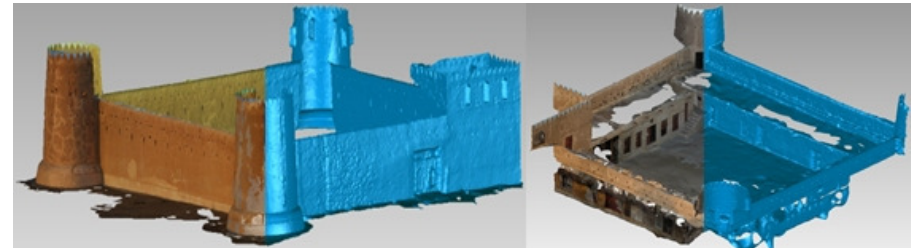
Figure 10: 3D surface model of the exterior walls (left) and the interior area (right) of the fortress Al Zubarah with and without texture generated with Autodesk web service 123D Catch beta